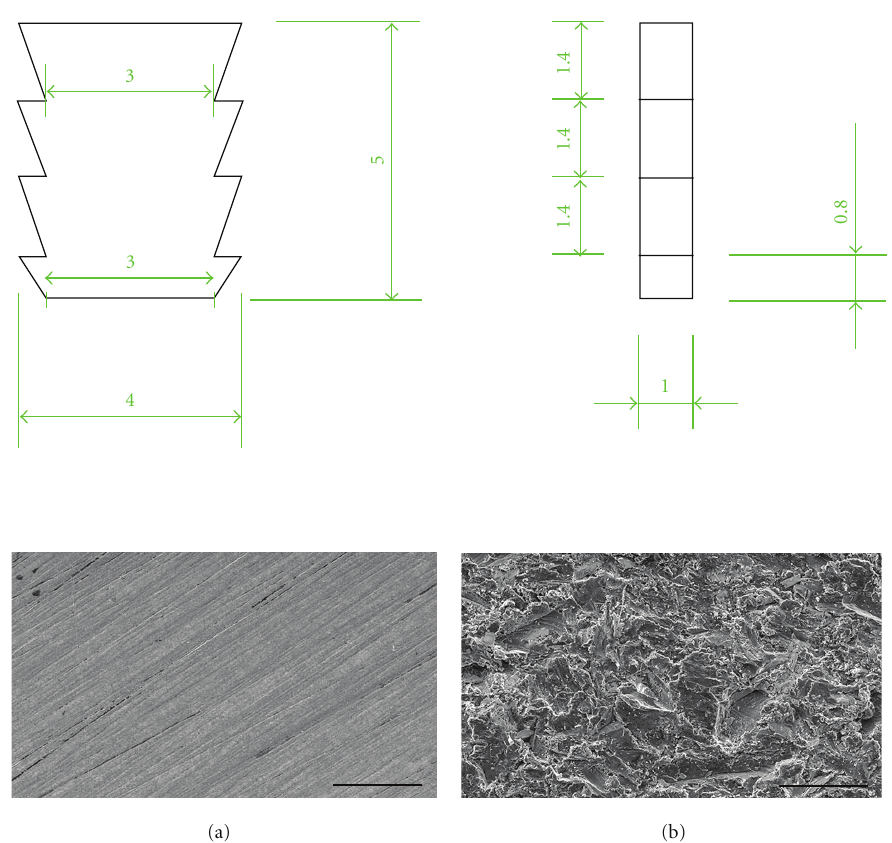
Figure 1: Top. Technical drawing of the tested implant devices. Bottom. SEM images of MS (a) and SLA (b) surfaces. Bar = 50 µ m.